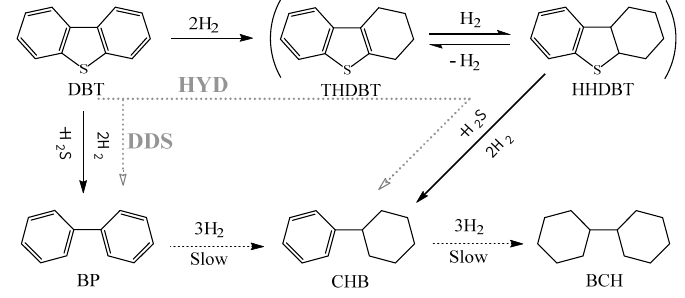
Scheme 1. Simplified reaction pathways for the HDS of DBT.